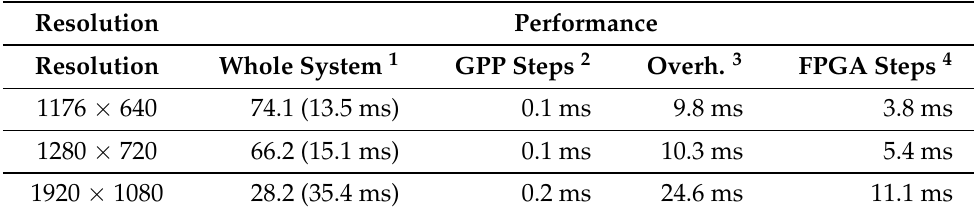
Table 1. Processing performance of the PCP System na plataforma HARPv2. The operating frequency of the detection and stereo matching modules in all configurations was 150 MHz.